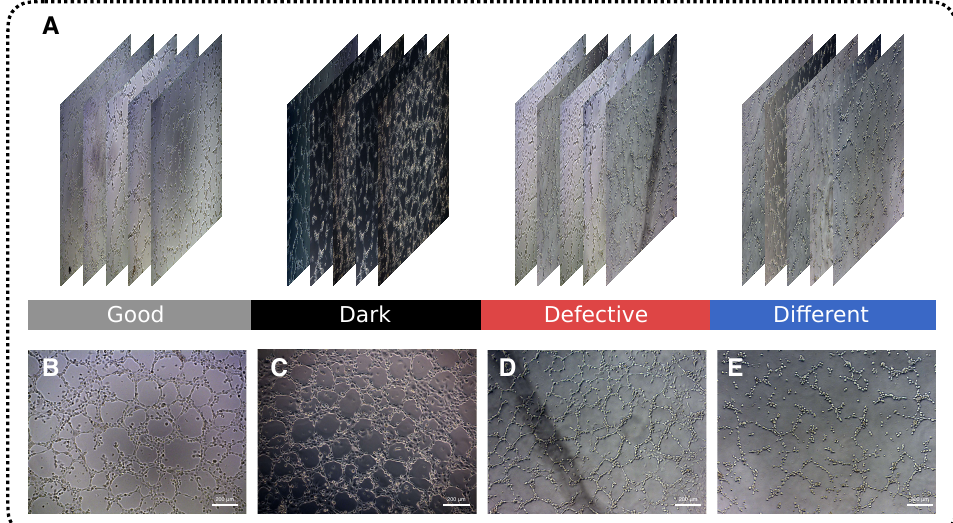
Figure 6. Original dataset consisting of 4 image categories ( A ) Good, Dark, Defective, and Different. ( B ) Image of good quality, easily recognisable structures; ECs were incubated for 24 h. ( C ) Image with altered light, darker than normal; ECs were incubated for 24 h. ( D ) Image with extraneous objects, such as shadows and defocus; ECs were incubated for 24 h. ( E ) Image from the early stages of angiogenesis; ECs were incubated for 10 h. Phase contrast, 100 ×